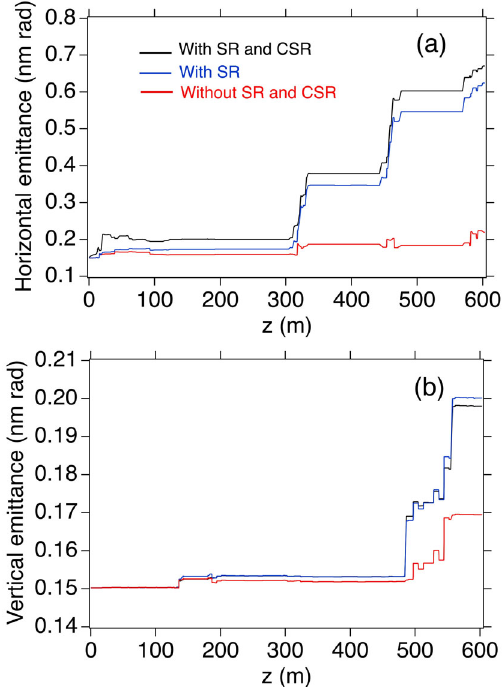
FIG. 8. Projected emittance growth along XSBT in the hori- zontal (a) and vertical (b) planes. Emittance is not normalized and the contribution of linear dispersion is subtracted. The calculation results are shown for three conditions: including SR and CSR effects (black lines), only SR effect (blue lines) and none of them (red lines). The initial beam has an 8 GeV beam energy, 150 pm rad emittance, a 20 fs bunch length (FWHM), 0.1% (rms) energy spread and a 200 pC bunch charge.